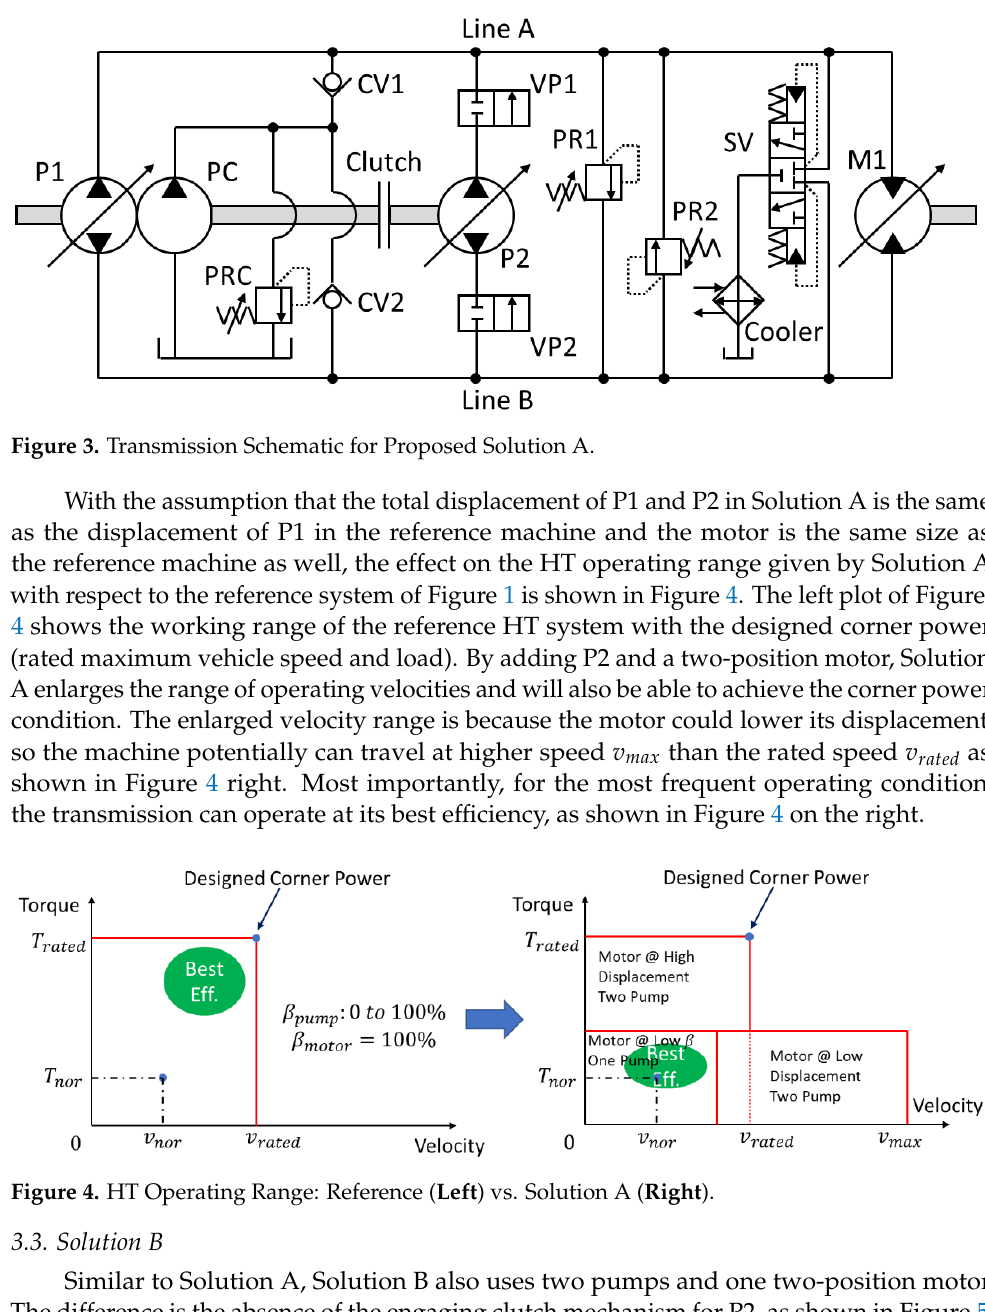
Figure 5. Transmission Schematic for Proposed Solution B. 3.4. Solution C Solution C is a one pump – one motor architecture, like the baseline system. However, Solution C uses a dual displacement motor instead of a fixed displacement one (Figure 6). As pointed out in [3] [6], this transmission type is more suitable for high TCF values, allowing for better engine utilization in terms of power. The solution has a limited cost increase, compared to the previous Solution A and B.